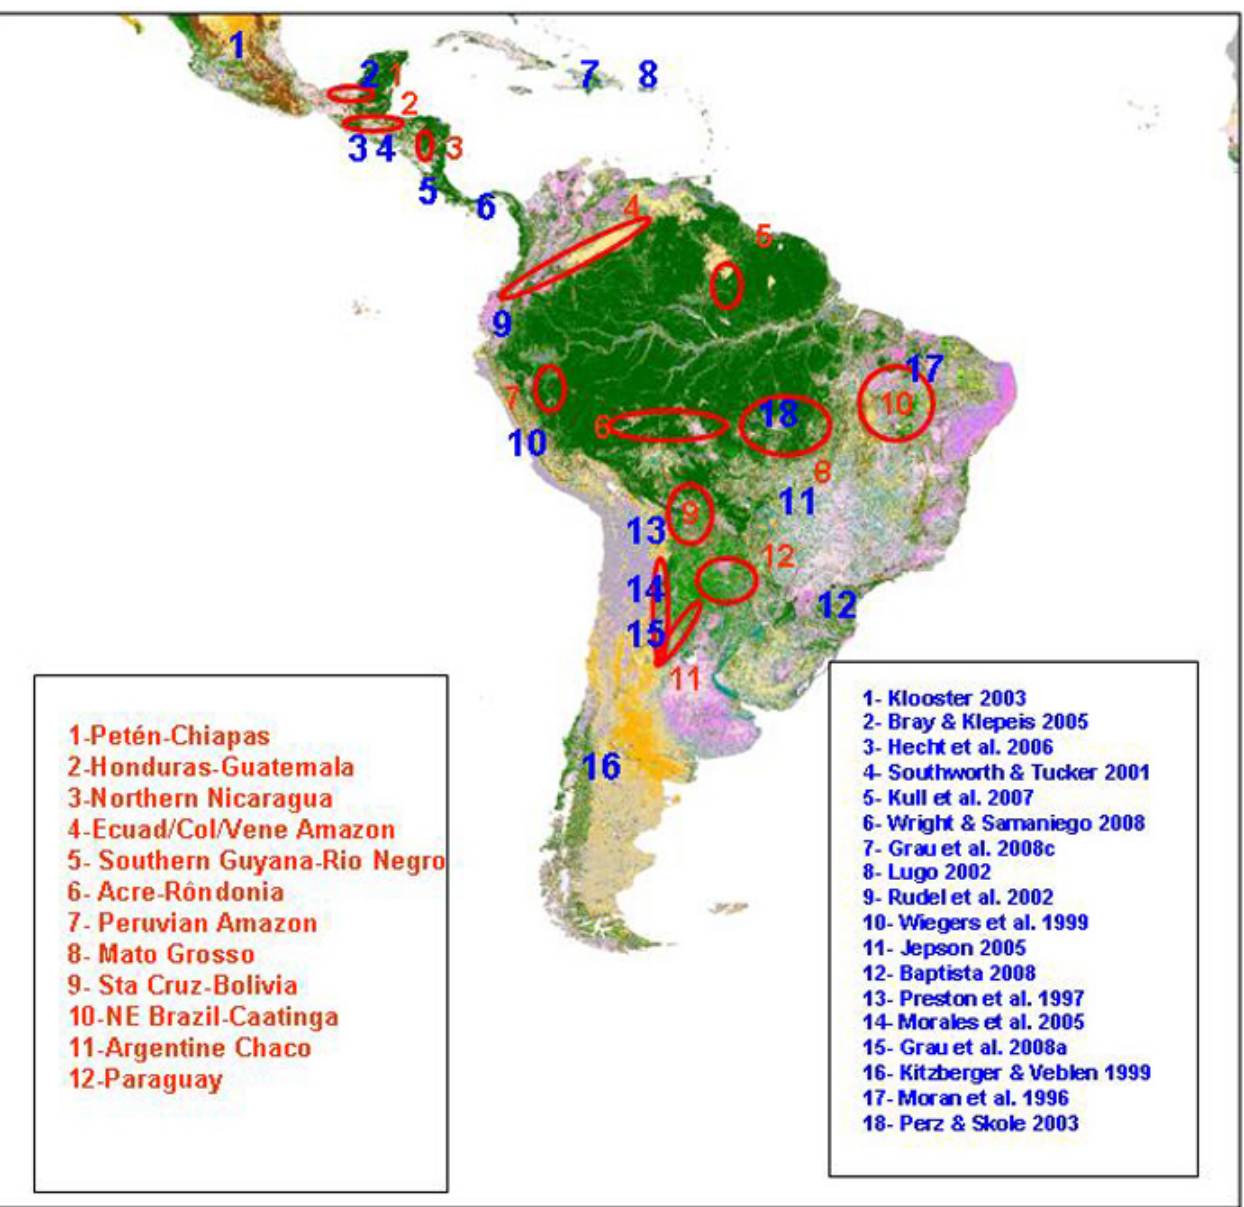
Fig. 1. Map of Latin America main biomes (based on Eva et al. 2004), showing the main deforestation fronts (in red, based on Food and Agriculture Organization (FAO) 2003, Gasparri et al. 2008), and selected case studies of ecosystems regeneration (in